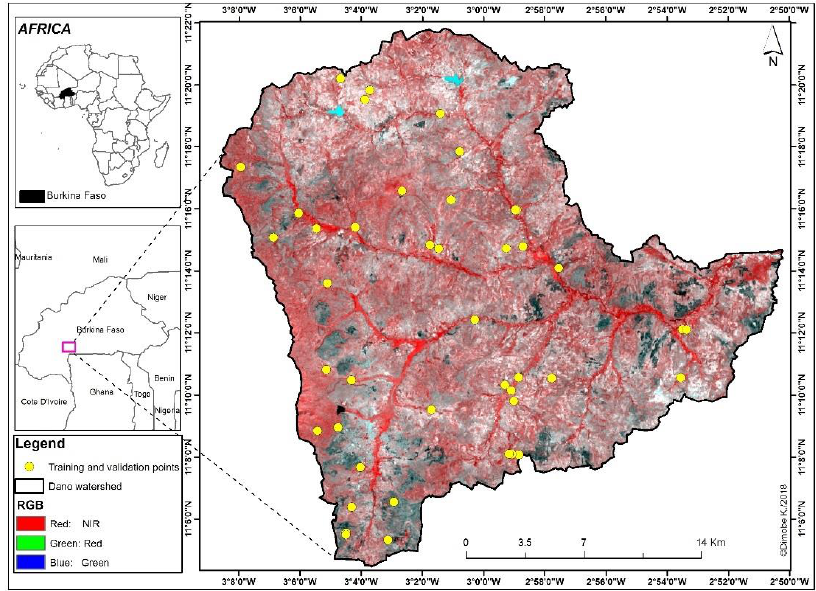
Figure 1. Map of study area showing the location of training and validation samples.